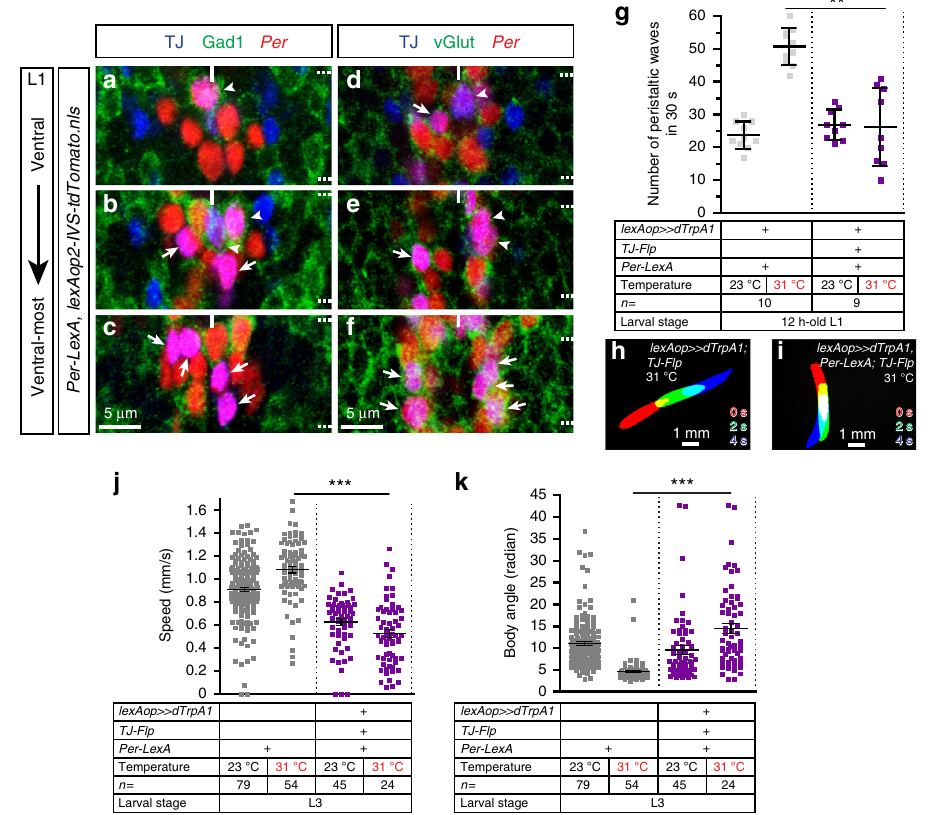
Fig. 7 Activation of TJ + / Per + INs reduces crawling speed and triggers active head casts. a – c Staining for TJ (blue), Gad1 (green), and nls-tdTomato (red) driven by Per-LexA in freshly hatched fi rst instar larva VNC. Staining reveals nine TJ + / Per + cells per segment, located in the ventral part of the VNC. The three most dorsal cells, located at the midline, are GABAergic (full arrowheads), while the six other cells are not (arrows). Note that one of the TJ + / Per + GABAergic neurons (often the most dorsal) is weakly Per + . d – f Staining for TJ (blue), vGlut (green), and nls-tdTomato (red) driven by Per-LexA in freshly hatched fi rst instar VNC. Six TJ + glutamatergic cells per segment can be visualized (arrows) while the three other TJ + / Per + cells are not (full arrowheads, presumably GABAergic). g Number of peristaltic waves per 30 s at (23 °C) and (31 °C) done by larvae expressing TrpA1 in TJ + / Per + neurons (purple dot plot) versus controls that do not express TrpA1 (gray dot plot). Activation of the TJ + / Per + population (nine cells per segments) leads to a decrease in the speed of locomotion of 12-h-old larvae (purple dot plot). Error bars indicate the mean ± SD and n the number of larvae tested. Statistical analysis: Kruskall – Wallis ** p ≤ 0.01. h , i Superimposition of three consecutive time frames (0, 2, and 4 s) showing the postures of third instar larvae: control larva ( h ) and upon activation of the TJ + / Per + population ( i ). j Speed of larvae expressing TrpA1 in TJ + / Per + neurons (purple dot plot) versus their respective controls that do not express TrpA1 (gray dot plot). k Body angle (in radian) of larvae expressing TrpA1 in TJ + / Per + neurons (purple dot plot) versus their respective controls that do not express TrpA1 (gray dot plot). j , k Statistical analysis: Z -test. *** p ≤